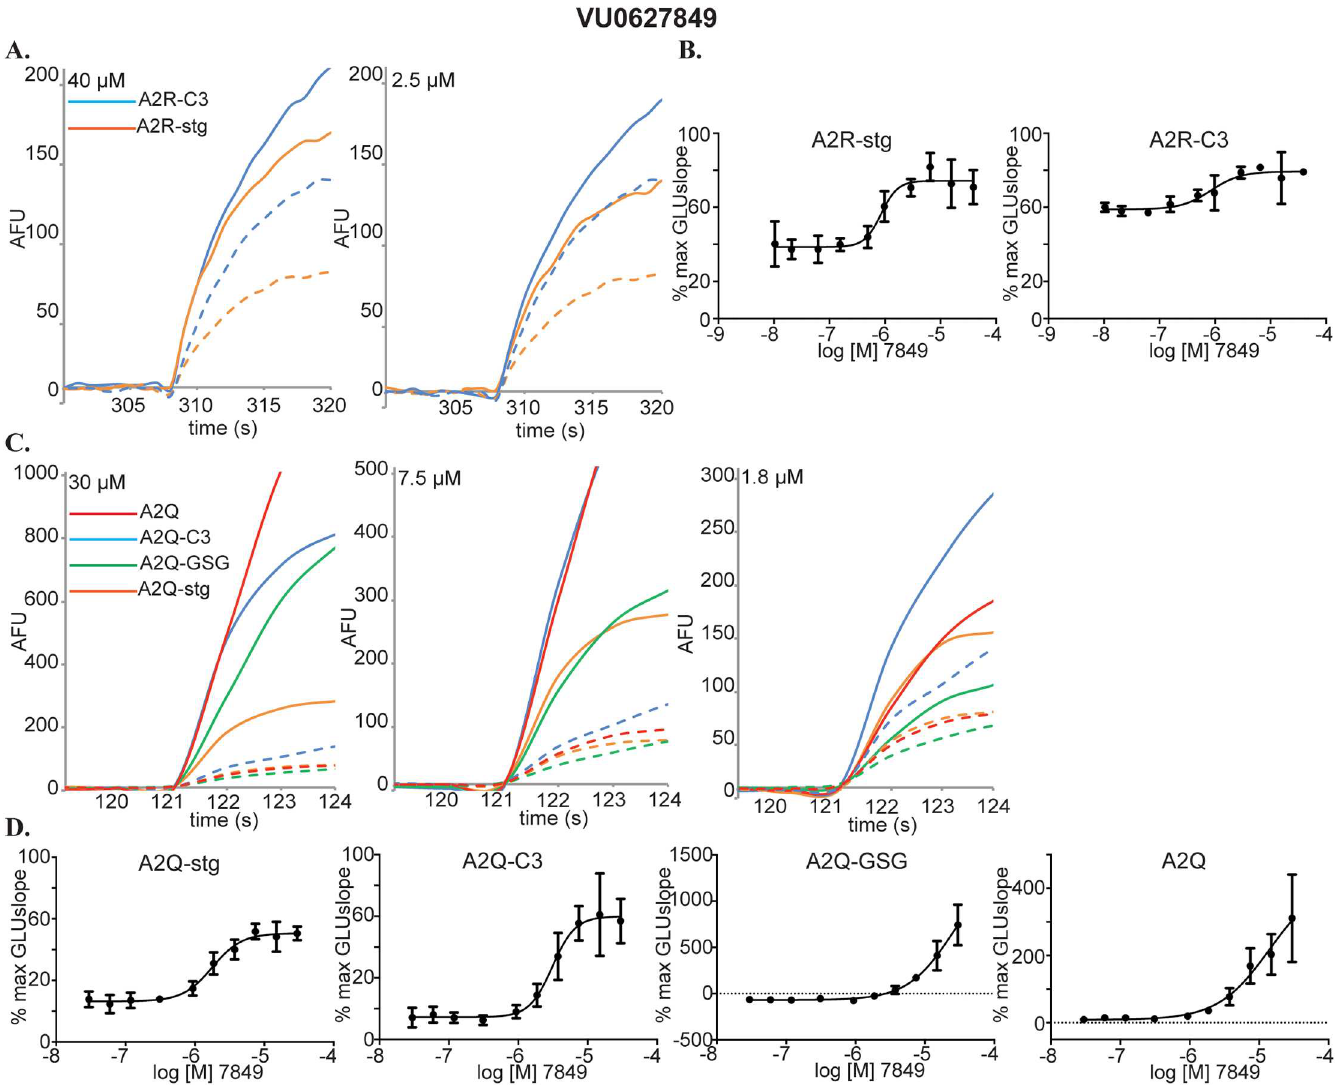
Fig 8. Characterization of VU0627849. (A) Raw data for compoundCRCs in the VSD assay. A2R-stg (orange)and A2R-C3 (blue). EC 50 GLU traces are representedby dashed lines. Concentrations of compoundare indicatedin the top left corner. (B) CRCs calculatedfrom GLUslope in the VSD assay for A2R-stg and A2R-C3. (C) Raw data for compoundCRCs in the calcium flux assay. A2Q (red), A2Q-stg (orange), A2Q-GSG (green), and A2Q-C3 (blue). 1 mM glutamatetraces are represented by dashedlines. (D) CRCs calculatedfrom GLUslope1 in calcium flux assay for A2Q-stg, A2Q-C3, A2Q-GSG, and A2Q cell lines. Plotted as %max GLUslopevs. log